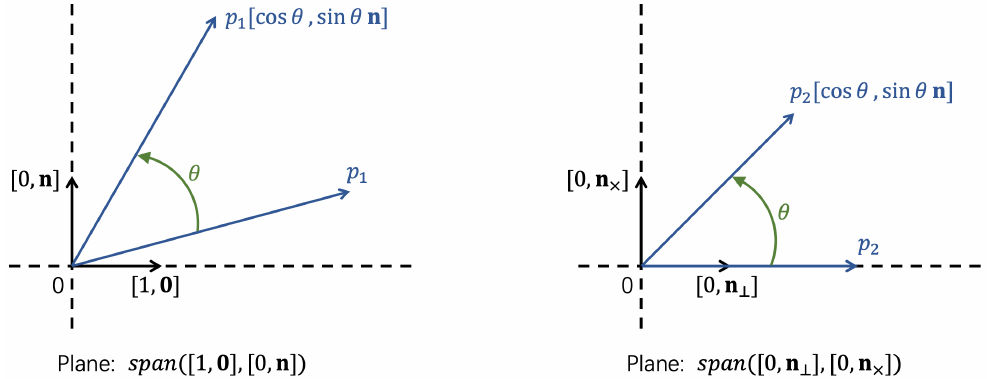
Figure 1. How do p 1 and p 2 rotate when they are multiplied by [ cos θ ,sin θ n ] on the right. As a special case, when u = 0 or u is parallel with n , p = p 1 . Thus at that time, p [ cos θ , sin θ n ] only means the rotation in plane span ([ 1, 0 ] , [ 0, n ]) . Moreover, the geometric meaning of qp is almost the same with pq , except that the rotation for p 2 is